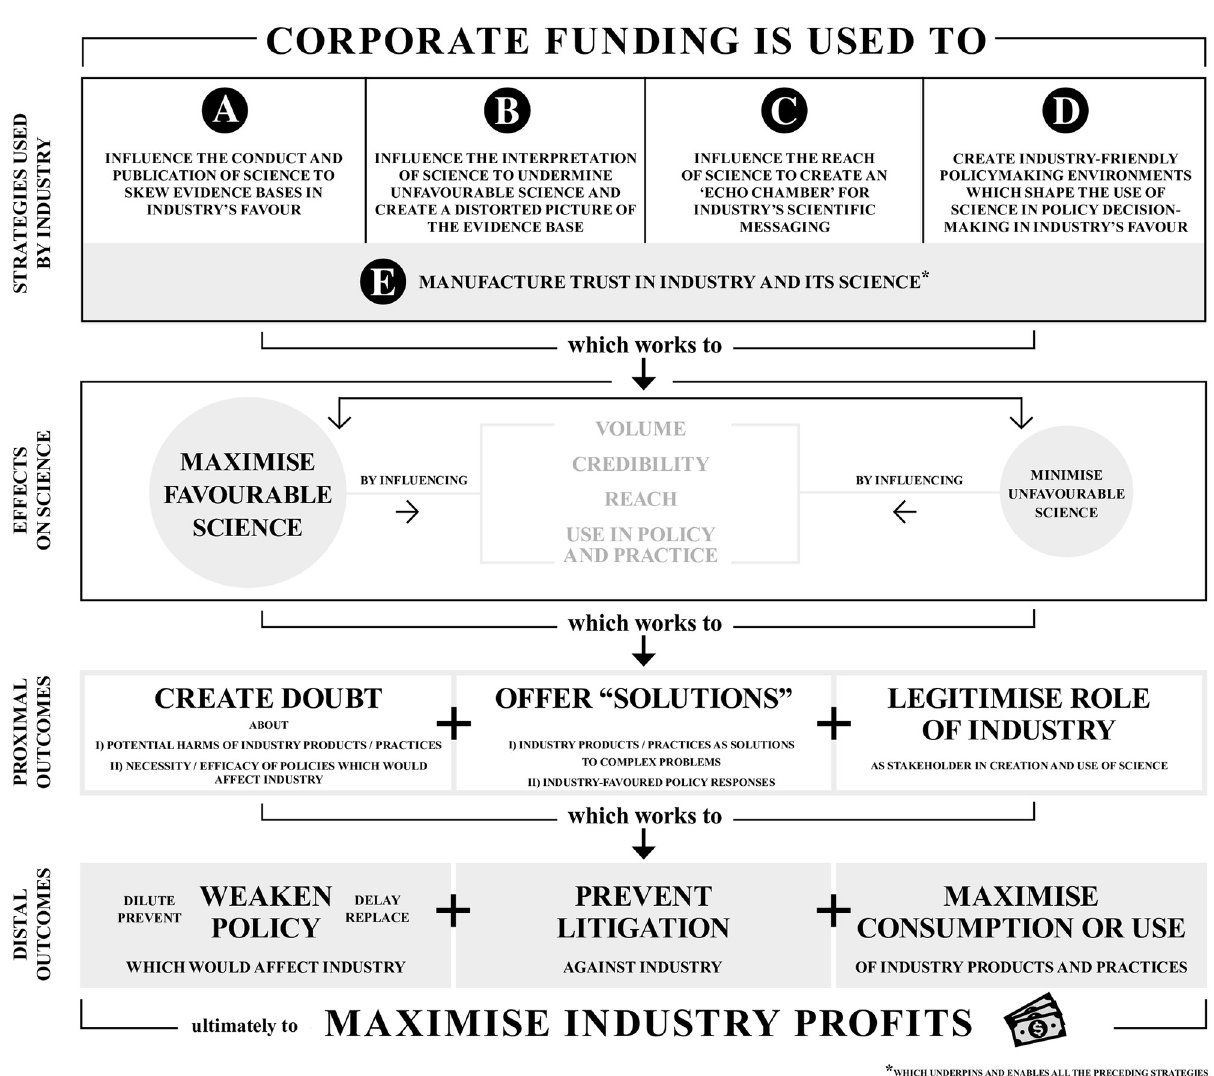
Fig 2. The Science for Profit Model—Corporate influence on science and the use of science in policy and practice—Strategies, effects, and outcomes.